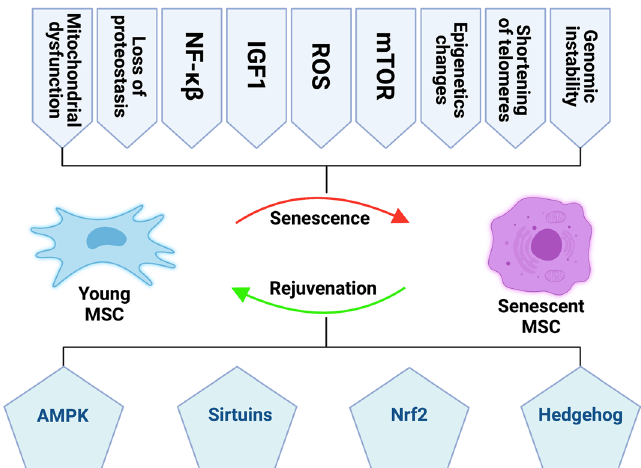
Fig. 2 Overview of MSC senescence homeostasis. Signaling pathways, AMPK, sirtuins, Nrf2, and Hedgehog induce antisenescence effects (green), whereas signaling pathways, mTOR, ROS, IGF1, and NF‑κB activate senescence (red) in MSCs. Genomic instability, telomere attrition, epigenetic alteration, mitochondrial dysfunction, and failed proteostasis induce MSC senescence